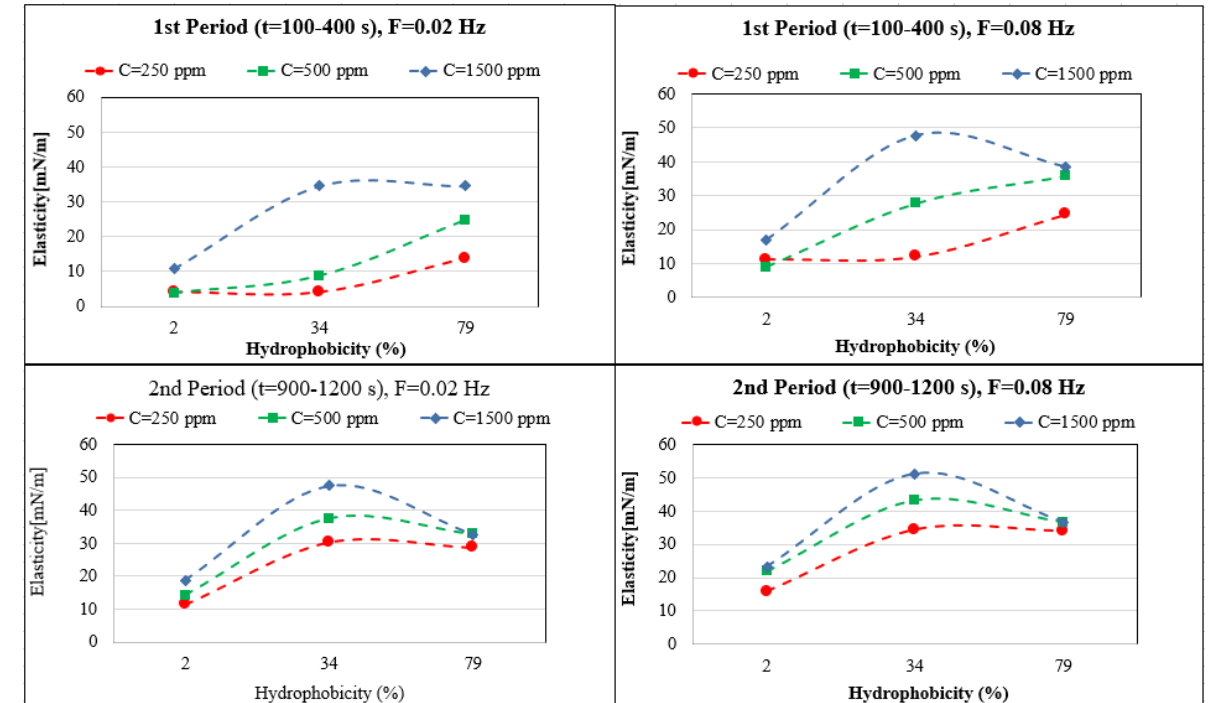
Figure 5. Dependency of the interfacial dilational elasticity on the bacteria’s hydrophobicity for different adsorbed layer age and applied frequency F.